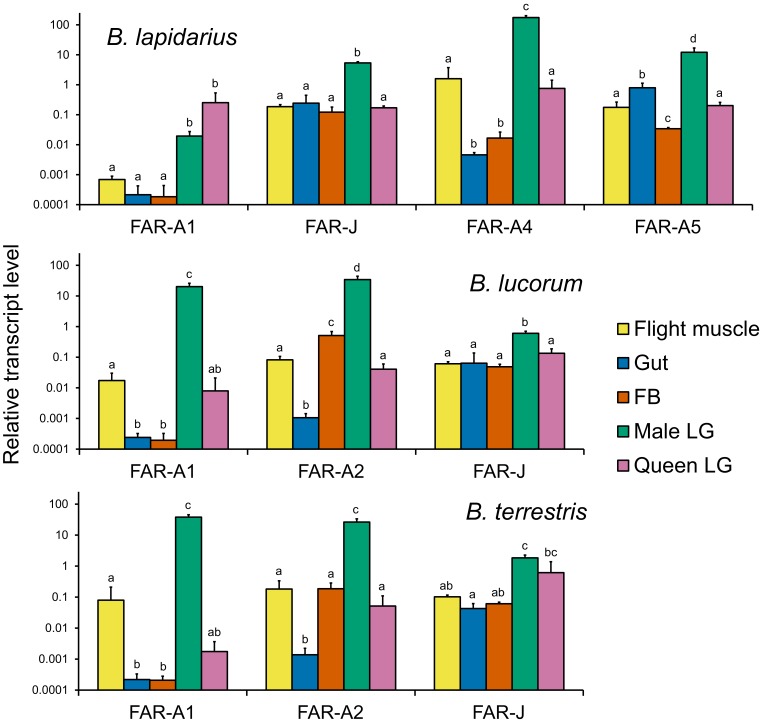
Relative expression of FAR candidates in the tissues of B. lapidarius, B. lucorum and B. terrestris males and queens.The FAR transcripts were assayed using RT-qPCR on cDNA from tissues of 3-day-old B. lapidarius, B. lucorum and B. terrestris males and queens (N = 3; queen LG: one biological replicate represents tissues from two queens). Significant differences (p < 0.05, one-way ANOVA followed by post-hoc Tukey’s HSD test) are marked with different letters; the statistical testing was performed on Cp difference values.10.7554/eLife.39231.018Figure 4—figure supplement 1—source data 1.List of relative transcript levels and Cp values for FAR candidates.The file contains a list of relative transcript level and individual Cp values for all assayed FAR and reference transcripts and results of statistical testing.